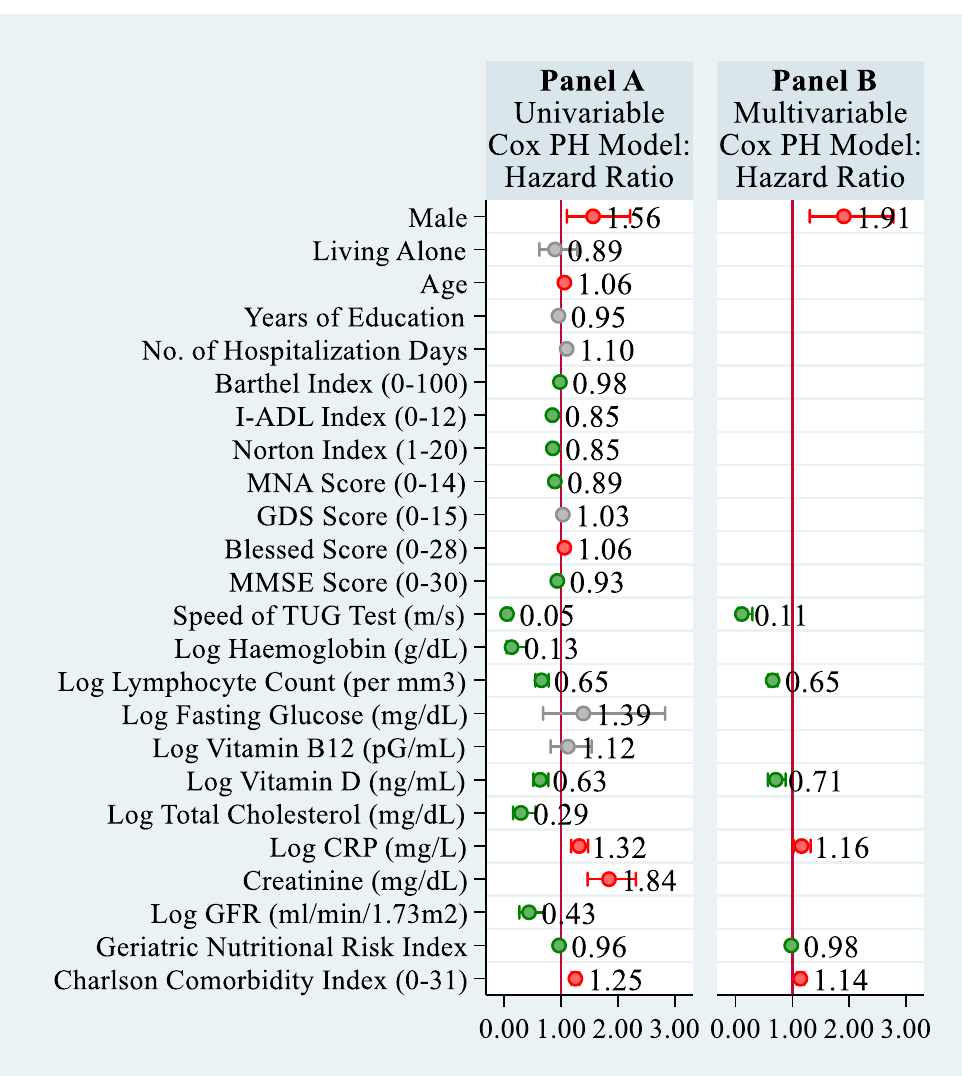
Figure 1. Association between the sociodemographic and health-related characteristics of former geriatric patients and their mortality rate: Results from the univariable Cox PH model (panel A) and the multivariable Cox PH model obtained with the stepwise backward variable selection method with the significance level set as p <0.05 (panel B).